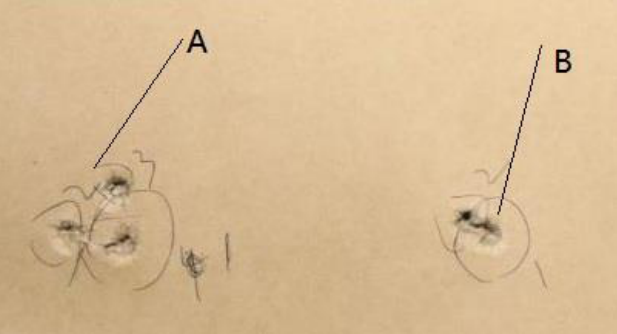
Figure 27. Shot image from Gatling gun. A — original Gatling gun; B — increase E Gatling gun. Record the target center and the center position of the two shooting methods, and shown in Figure 28 below, the unit X and Y is meter. The absolute value decreases the range of R60 m.